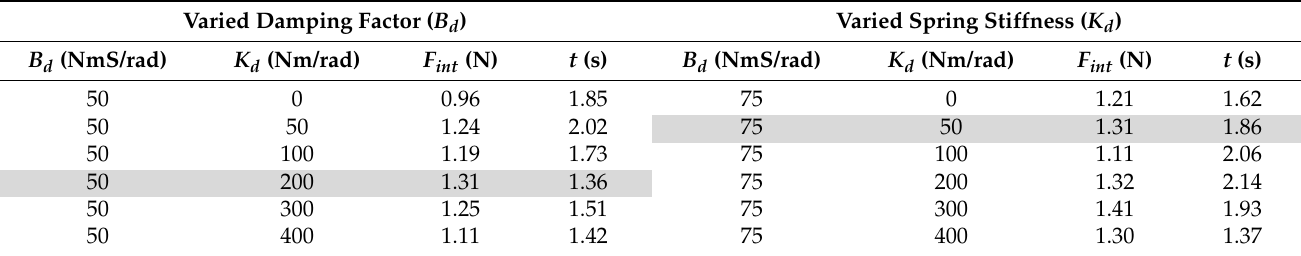
How do you compare the qualitative performance of the HHH to that of the HRH using the parameter Set 2? Table 2. Comparisons of the average interactive force ( 𝐹 𝑖𝑛𝑡 ) and time ( 𝑡) parameters, while varying both damping factor Table 2. Comparisons of the average interactive force ( F int ) and time ( t ) parameters, while varying both damping factor ( 𝐵 𝑑 ) and spring stiffness ( 𝐾 𝑑 ). ( B d ) and spring stiffness ( K d ).